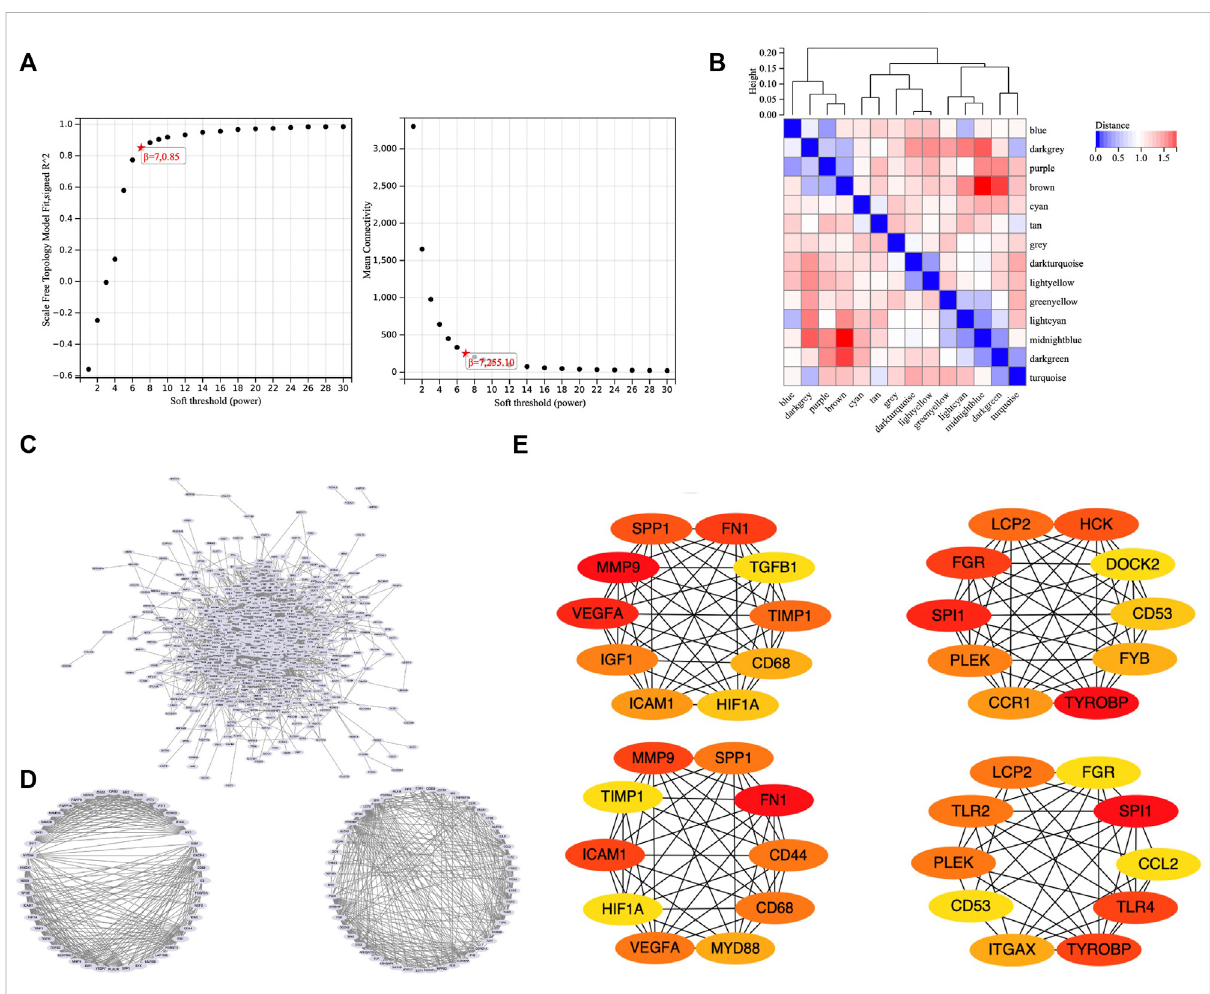
FIGURE 3 WGCNA andPPI. (A) Soft threshold power wassetto 7. (B) Hierarchical clustering treewas constructed for all genes, and14 important modules were identi fi ed. (C) A total of 687 genes were extracted from hub genes extracted from WGCNA and 1806 differentially expressed genes. (D)